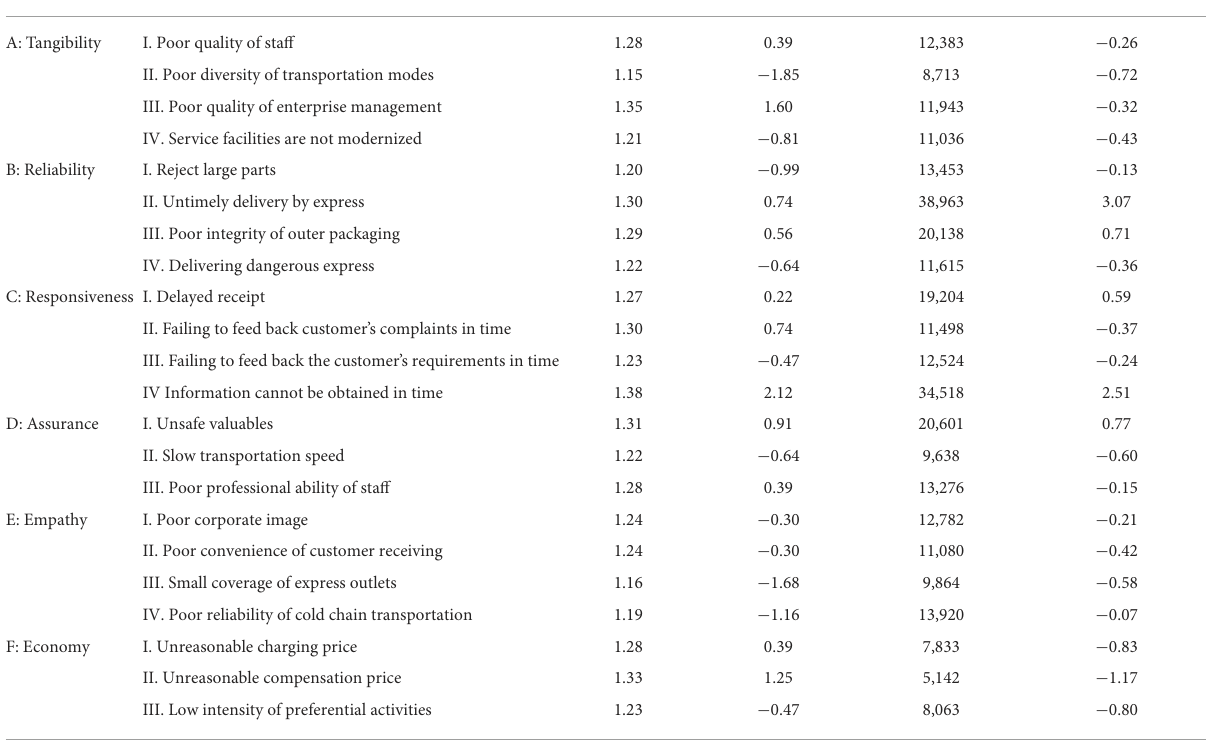
TABLE 4 The results of the degree value and attention value of express service defect. Defect type